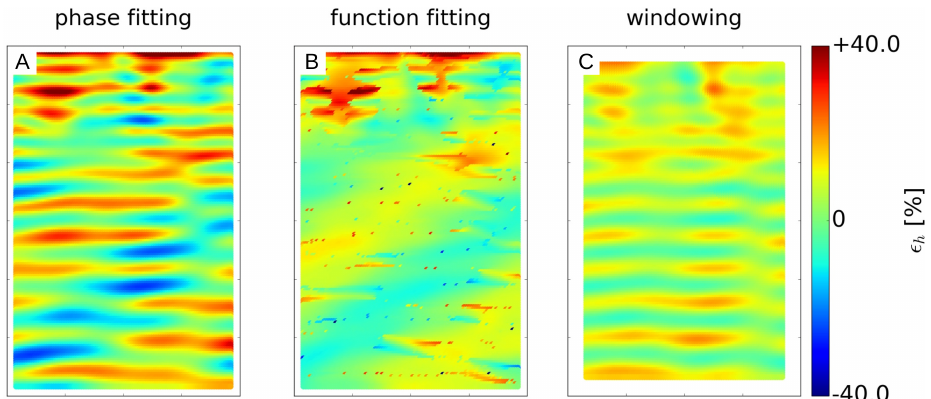
Figure 12. Results for (cid:101) h obtained with phase fitting ( A ), function fitting ( B ), and windowing ( C , with w t = 60 s) from the first mode for the nonlinear polychromatic wave field WS with F = 1.0, ∆ t = 0.532 s, ∆ x = 2 m, R t = 1.1 s, R x = 8 m, and t max = 150